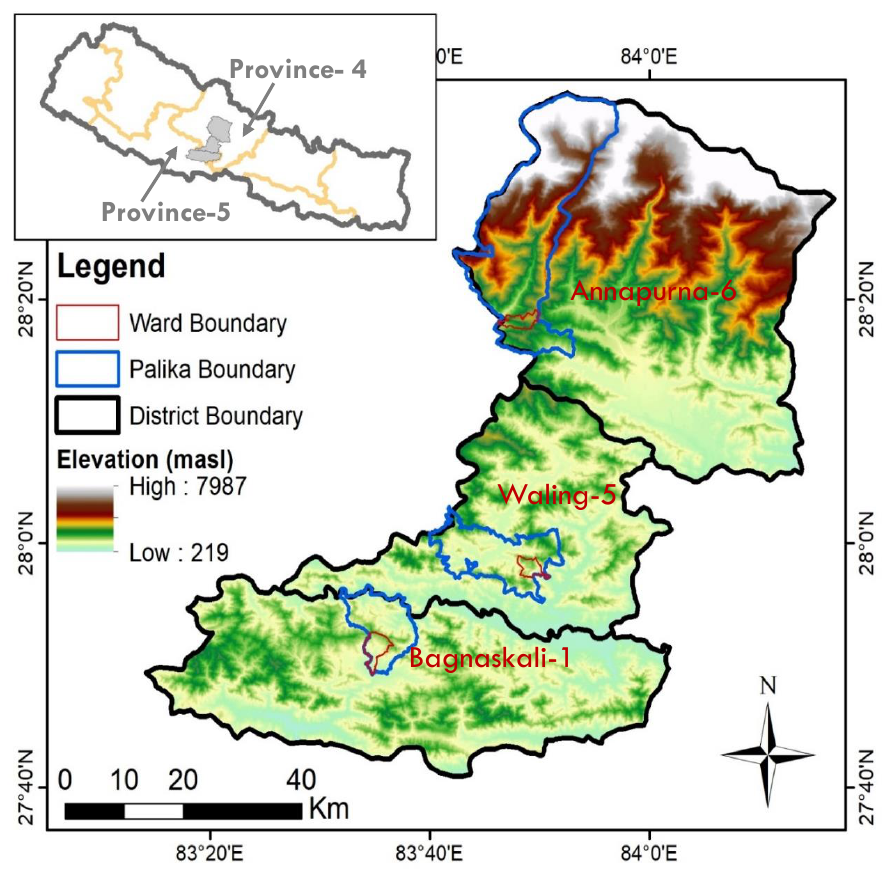
Figure 1. Study Figure 1. Study area.